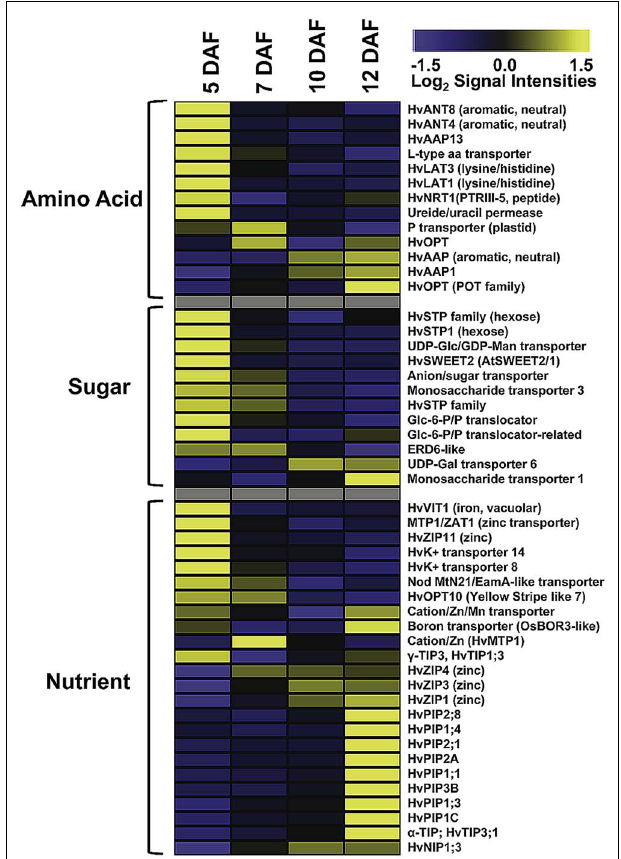
FIGURE 2 | Expression profiles of transporter genes in developing ETCs as determined by microarray analysis. Transcript levels are median-centered and log 2 -transformed.Transcript levels are indicated by color code: yellow, high; blue, low [data were selected from transcriptome analysis presented byThiel etal.